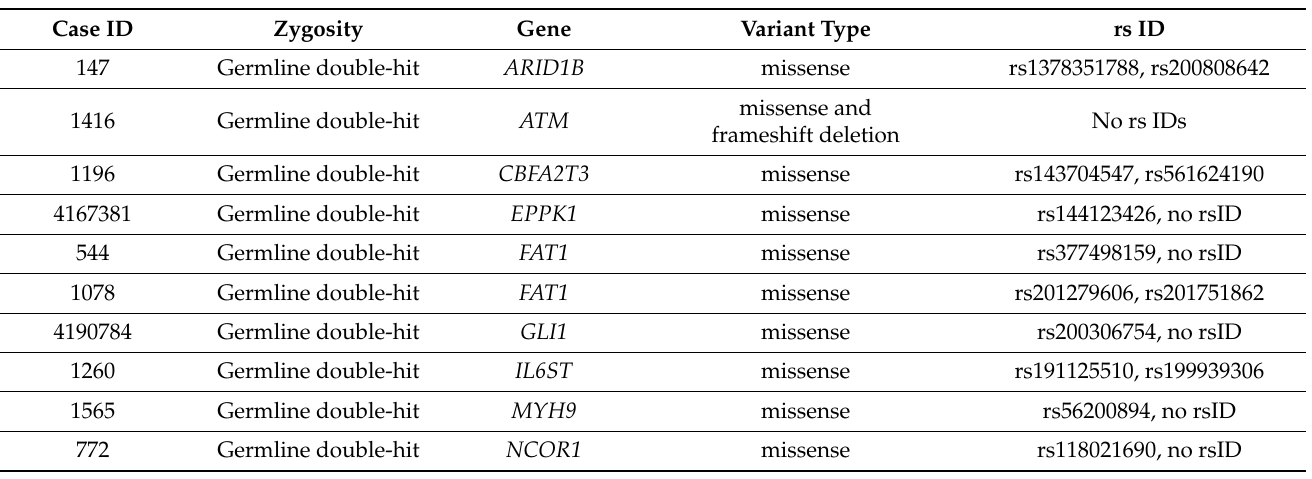
Table 2. List of all homozygous and germline double-hit rare and putatively dysfunctional variants detected across 726 patients with B-cell lymphoid